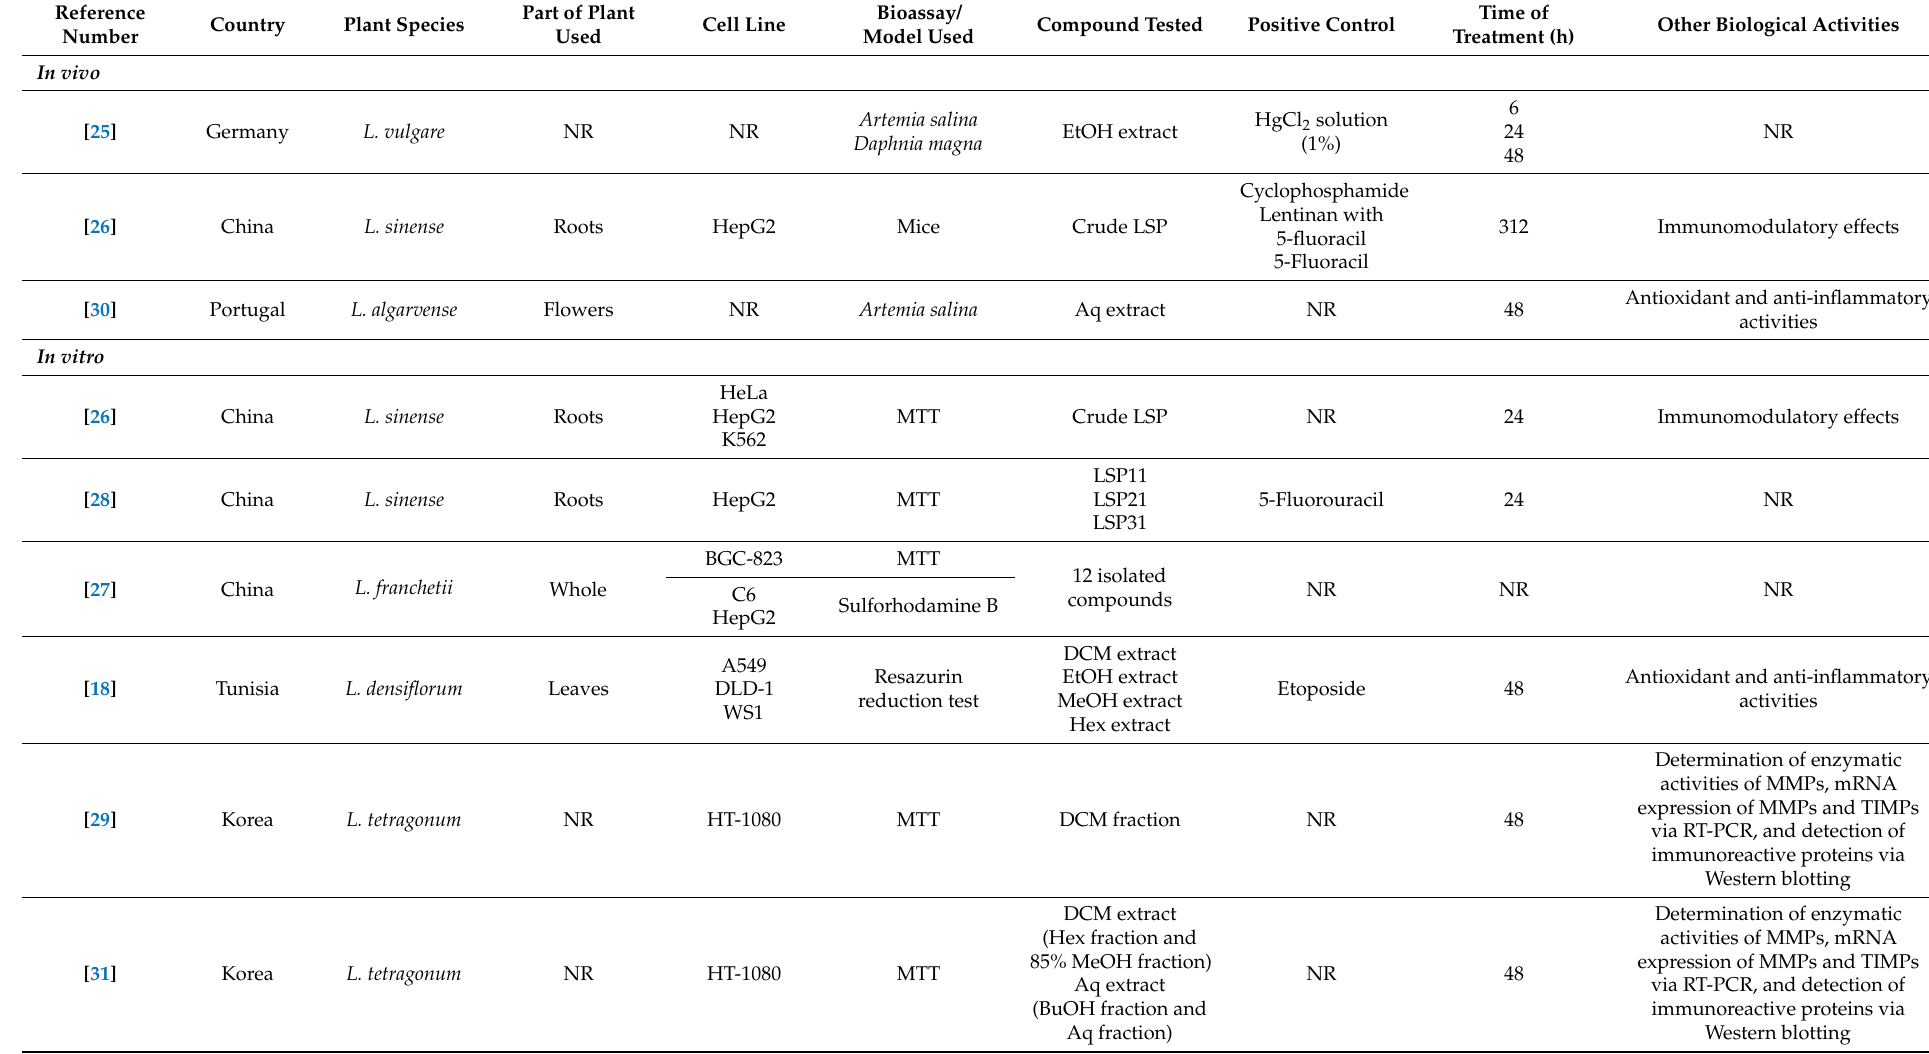
Table 1. Main characteristics of all eligible in vivo and in vitro studies included in the systematic